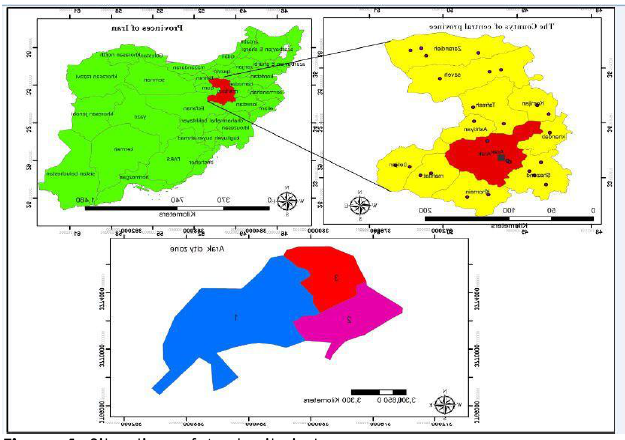
Figure 1. Situation of Arak city in